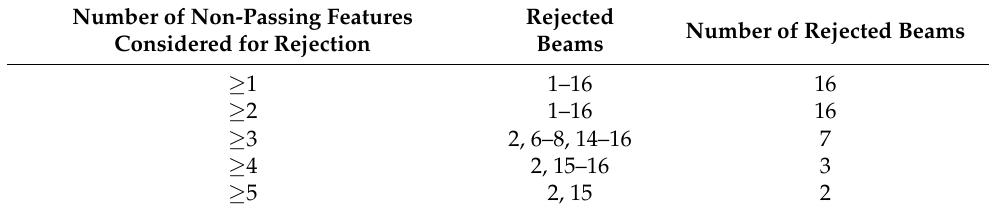
Table 7. Rejected beams as a function of the number of non-passing features considered for rejection. Number of Non-Passing